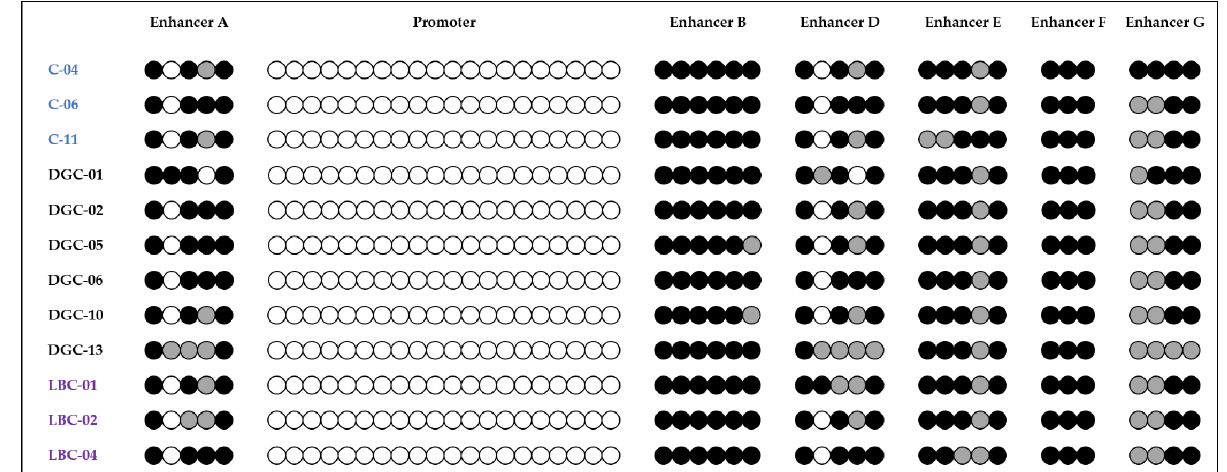
Figure 3. Methylation analysis of CDH1 promoter and enhancers on a selection of DNA samples from peripheral blood of three healthy individuals (in blue) and nine HDGC CDH1 -negative patients (six DGC patients in black and three LBC patients in violet). The complete case series is reported in Supplementary Figures S1 and S2. non-methylated CpG site; partially methylated CpG site; fully methylated CpG site; deletion.